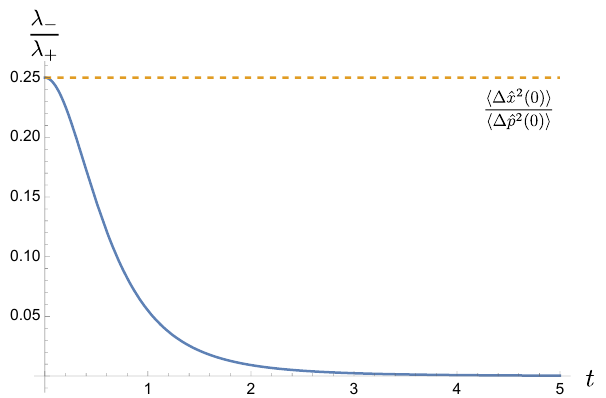
Figure 1. The time variation of the ratio of the eigenvalues of the covariance matrix. it shows the squeezing and stretching of the quadratures. In this case, the position dispersion is highly squeezed but the momentum is stretched. For a free particle of mass m and initial position dispersion σ , the ratio is asymptotically given by 4 m 4 σ 4 , and for the inverted harmonic oscillator, it behaves like t 4 λ − = 16 β 2 sin 4 2 θ e − 4 ω t , where the notations are explained in Section [ 4 β 2 + 1 +( 4 β 2 − 1 ) cos2 θ ] 2 λ +